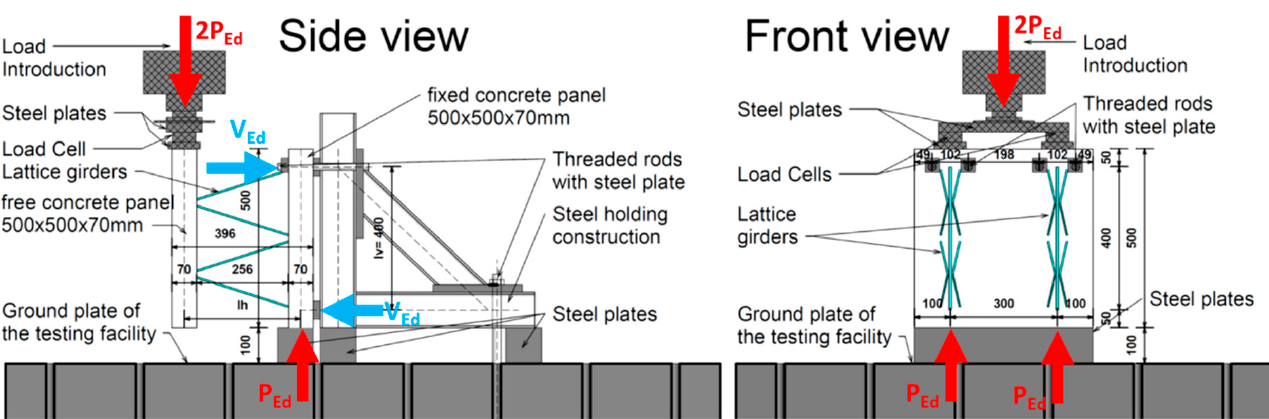
Figure 4. Test setup in side-view and front-view (free panel not displayed in front-view), units in mm.